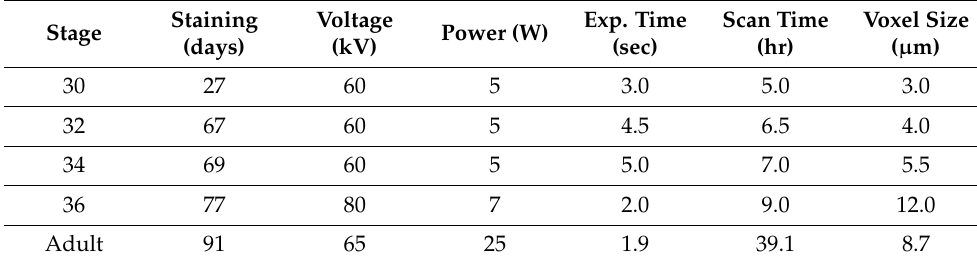
Table 1. Staining duration and imaging parameters of